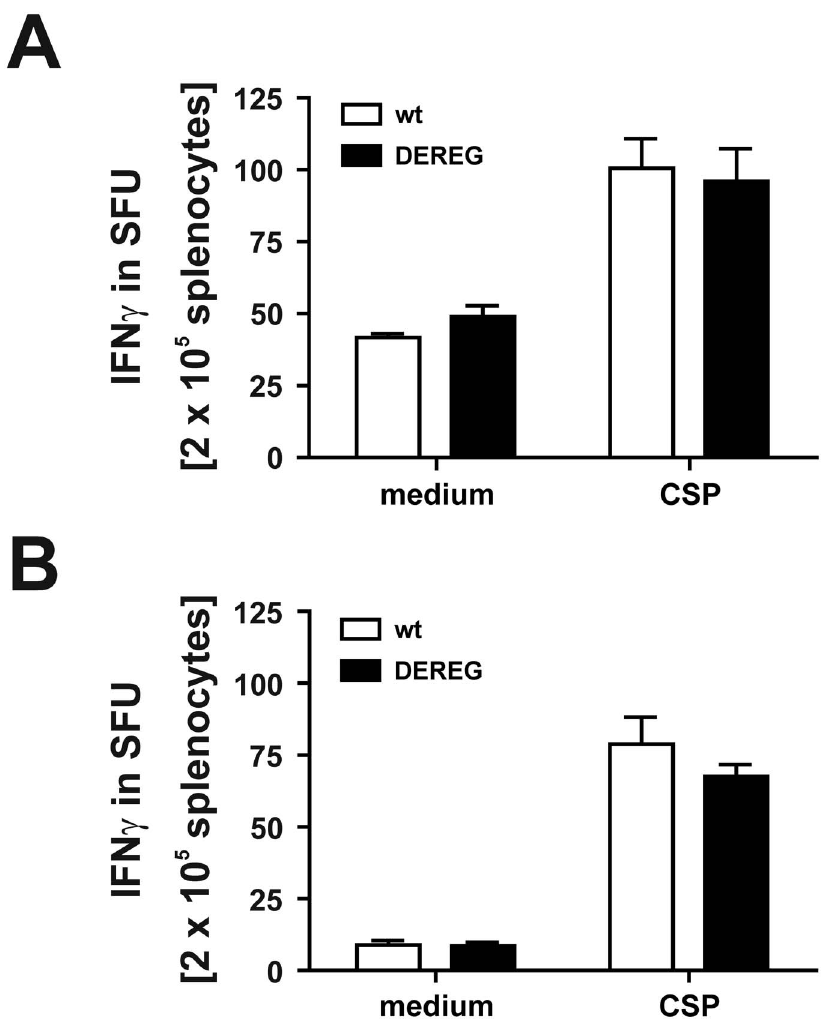
Figure 8. T reg -depletion during boost immunization does not affectmemory responses. BALB/c DEREG mice or non-transgenic littermates were immunized with ACT-CSP on day 0 and day 14. Both groups of mice were treated on days 15, 16 and 17 with DT. Spleen cells of mice were restimulated with CSP-peptide after (A) 6 weeks, and (B) 9 weeks. The number of IFN c producing T cells in spot forming units (SFU) was analyzed by ELISPOT. Data are expressed as mean + / 2 SD of 5 mice per group and time-point. This experiment was repeated once with similar